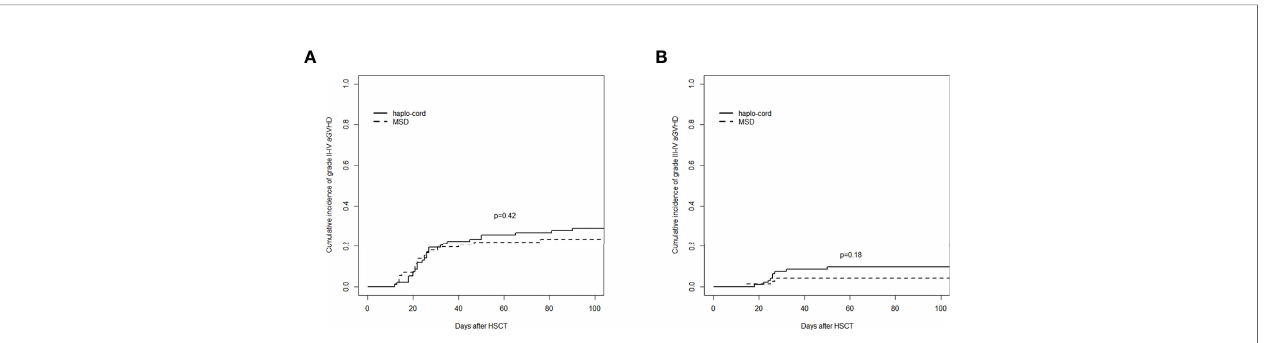
FIGURE 2 | Assessment of cumulative incidence of aGVHD in haplo-cord group and MSD group: (A) grade II – IV aGVHD and (B) grade III – IV aGVHD. aGVHD, acute graft-versus-host disease; MSD, matched sibling